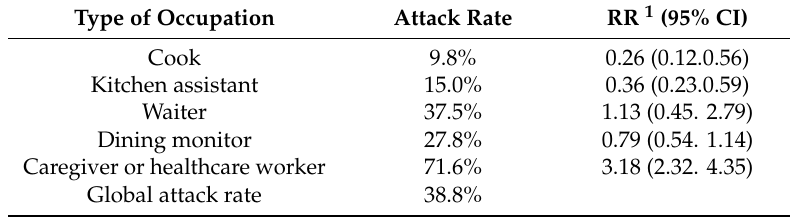
Table 4. Attack rates and rate ratios (RRs) in workers according to type of